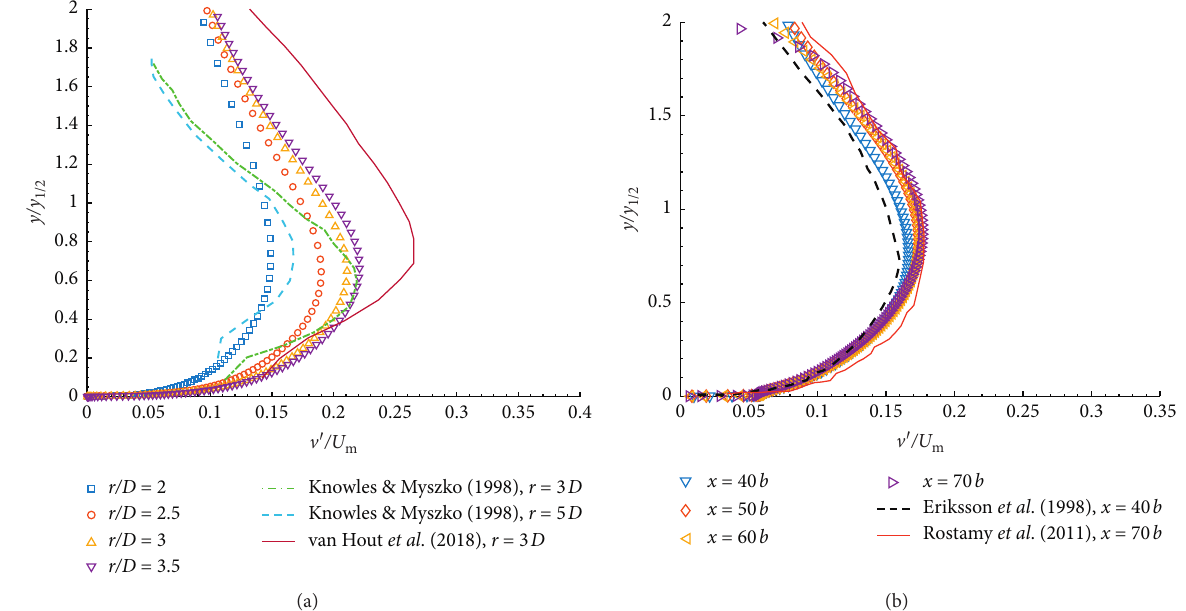
Figure 7: Profiles of vertical RMS velocity. (a) Radial wall jet. (b) Plane wall jet.